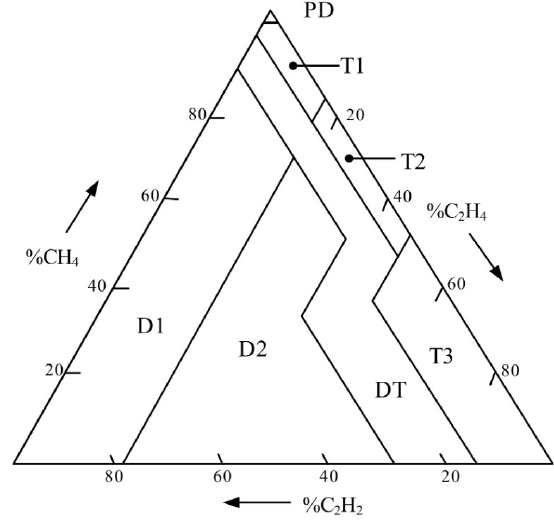
Figure 11. Duval Triangle for the OLTC. Table 4. A comprehensive comparison of the traditional DGA based on ratio methods in actual transformer fault diagnosis.